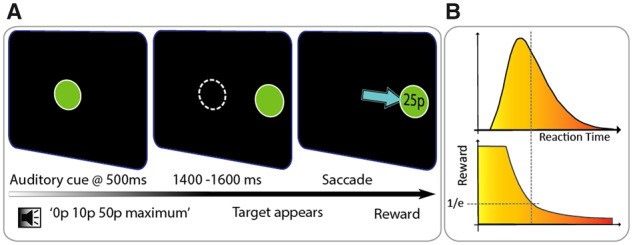

Experimental paradigm. (A) Participants were informed of the maximum reward available at the start of each trial with an auditory cue initiating 500 ms after trial onset: ‘0p/10p/50p maximum’. Subsequent to a randomized variable fore-period of 1400, 1500 or 1600 ms the central ﬁxation disc disappeared concurrently with the appearance of a new peripheral target disc. Participants’ rewards varied according to reaction time, and the obtained reward was displayed within the peripheral target disc in pence (e.g. 25p). (B) The absolute reward value obtained varied with reaction time, but importantly was dynamically adjusted according to each participant’s mean reaction time at any point during the experiment. Rewards obtained for each trial were calculated using an adaptive exponential fall-off based on the mean reaction time of the preceding 20 trials and, dependent on performance, participants received a proportion of the maximum amount on offer. This adaptive procedure allowed difﬁculty level to be kept constant over the experiment and crucially meant that all participants received the same overall reward amount. Therefore, it prevented some patients earning less as they progressed through the task while maintaining equal extrinsic incentivization.